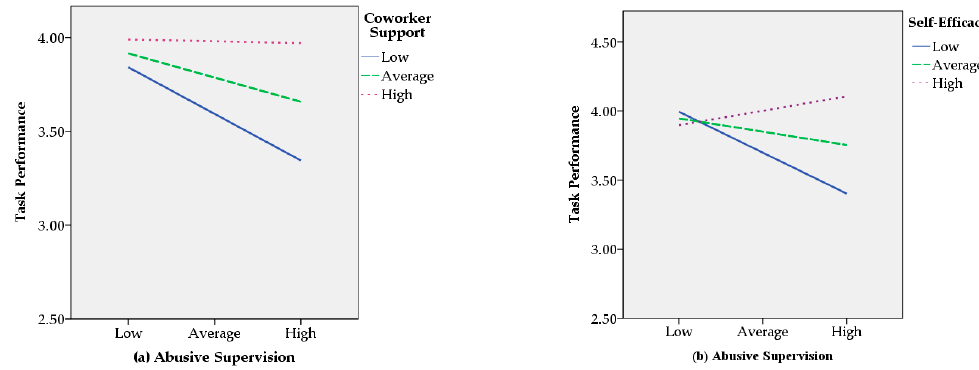
Figure 2. ( a ) Interaction Plot of Abusive Supervision and Coworker Support; ( b ) Interaction Plot of Abusive Supervision and Self-Efficacy. Table 2. Result of Stepwise Ordinary Least Squared (OLS) Regression Analyses.